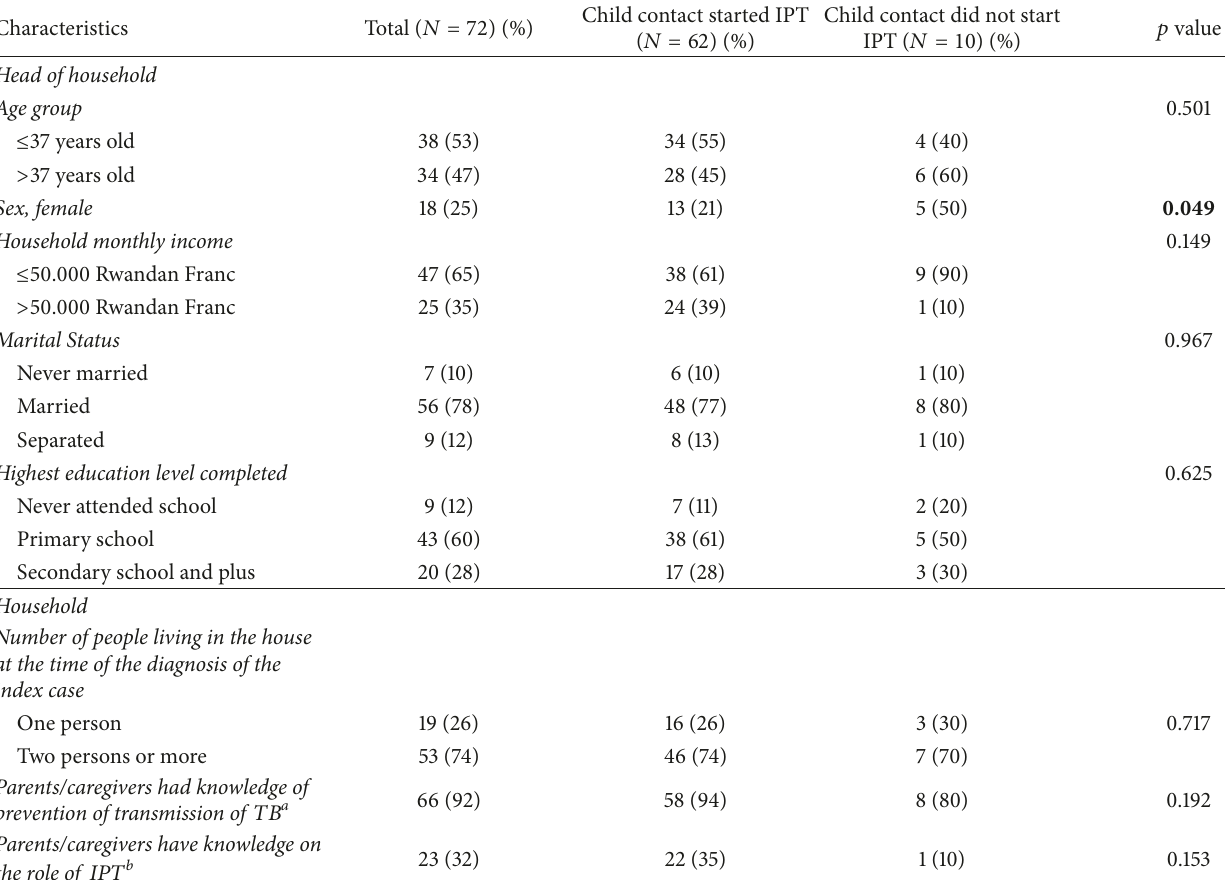
Table 2: Characteristics of the household of child contacts by uptake of